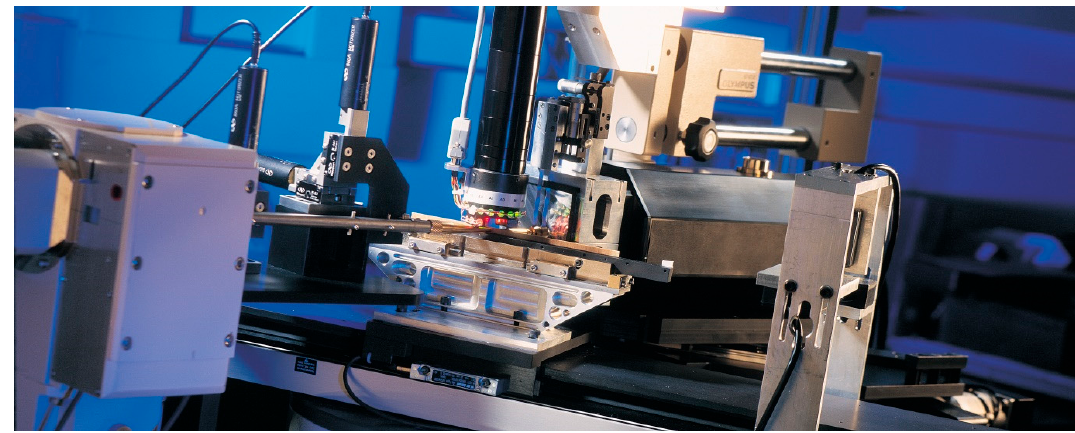
Figure 13. SilviScan-2.